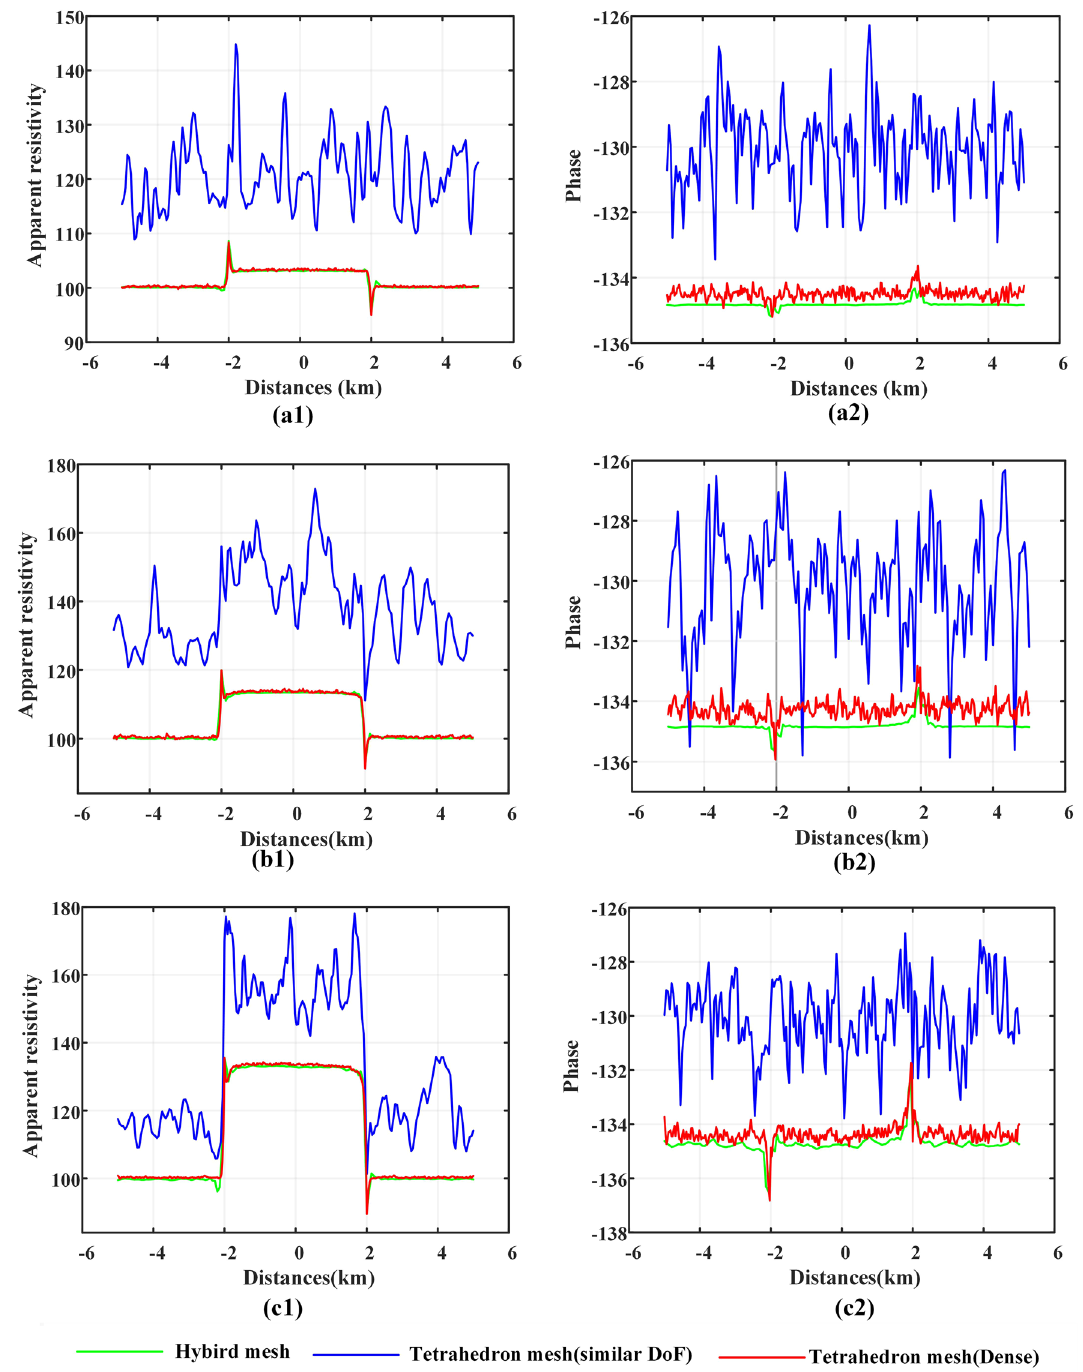
Figure 14. For the sloped terrain model, when the tilt angle changes, the MT response results of the yx component are calculated by different meshes. ( a 1), ( b 1) and ( c 1) represent the calculation results of the apparent resistivity, and ( a 2), ( b 2) and ( c 2) represent the calculation results of the phase. ( a ), ( b ) and ( c ) represent the calculation results when the tilt angle is 10, 20, and 30 degrees,